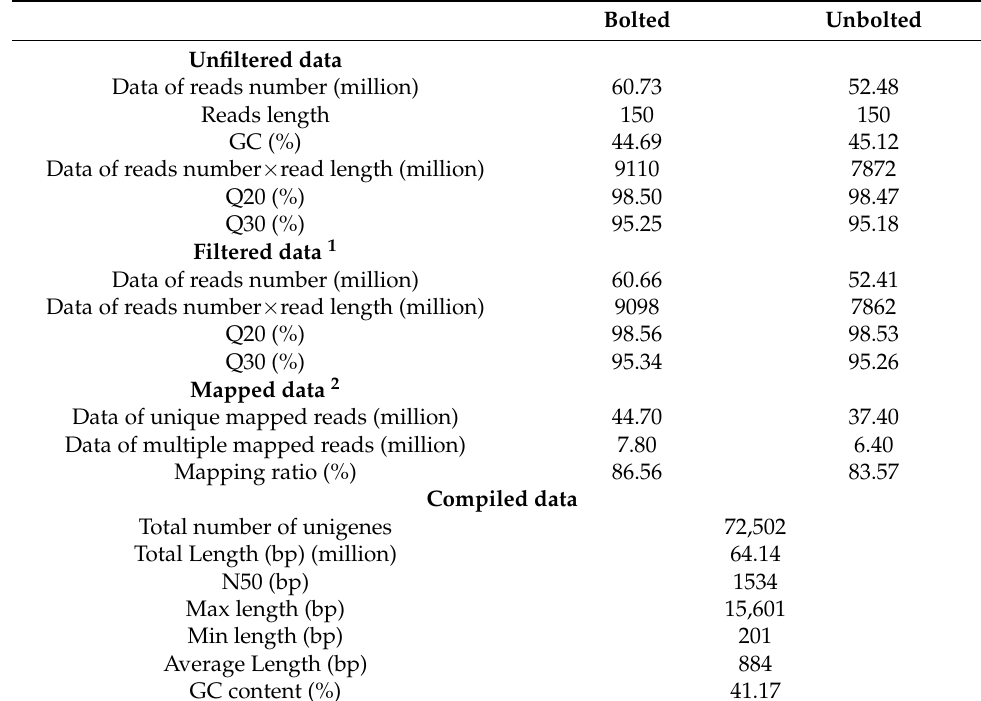
Table 1. Summary of sequencing data for Angelica sinensis transcriptome.